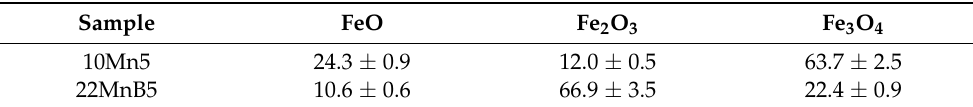
Figure 6. X-ray diffraction pattern of the scale spalling off, ( a ) 10Mn5 steel; ( b ) 22MnB5 steel. Table 3. The fraction of each phase (calculated by the adiabatic principle) in the surface oxide of the sample (wt.%).